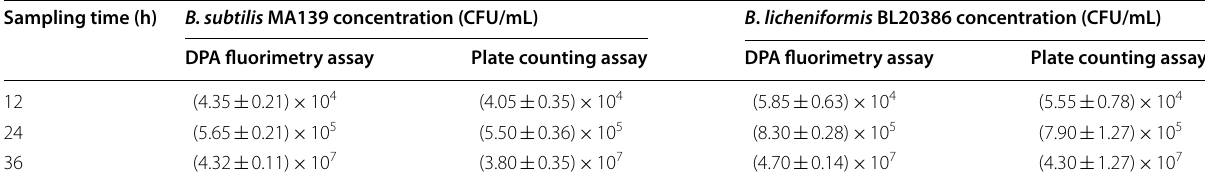
Table 1 The confirmative results on spore detection by DPA fluorimetry assay of B. subtilis MA139 and B. licheniformis BL20386 compared with Plate counting